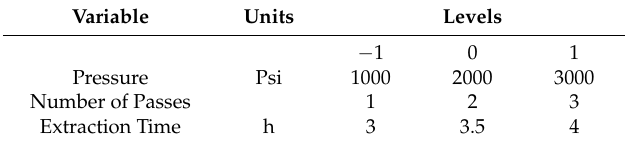
Table 1. Response Surface Methodology (RSM) table for design and coded values for input parameter.